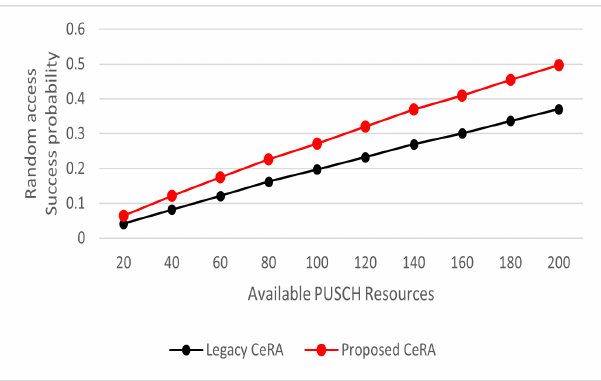
Figure 10. RA success rates for different available PUSCH